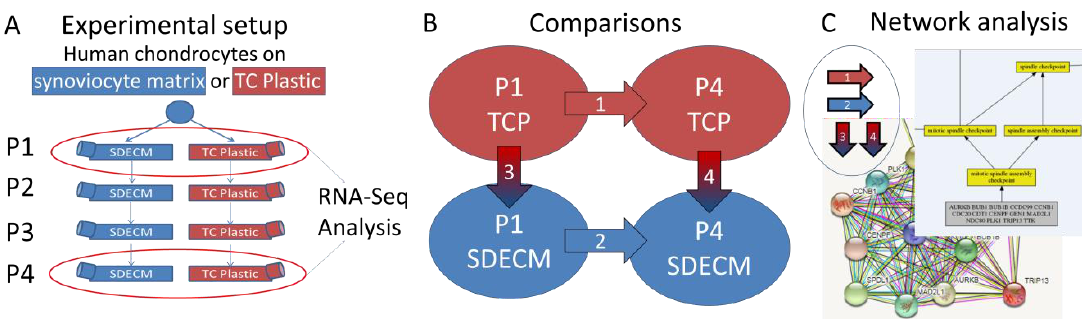
Figure 1. Experimental outline and comparisons. ( A ) Experimental setup: human articular chondrocytes were thawed from frozen stocks and seeded onto both synoviocyte-derived extracellular matrix (SDECM) and tissue culture plastic (TCP) flasks, passaged 4 times and RNA collected at passage (P) P1 and P4 for RNA sequencing (RNA-Seq) analysis. ( B ) Comparisons of gene expression profiles